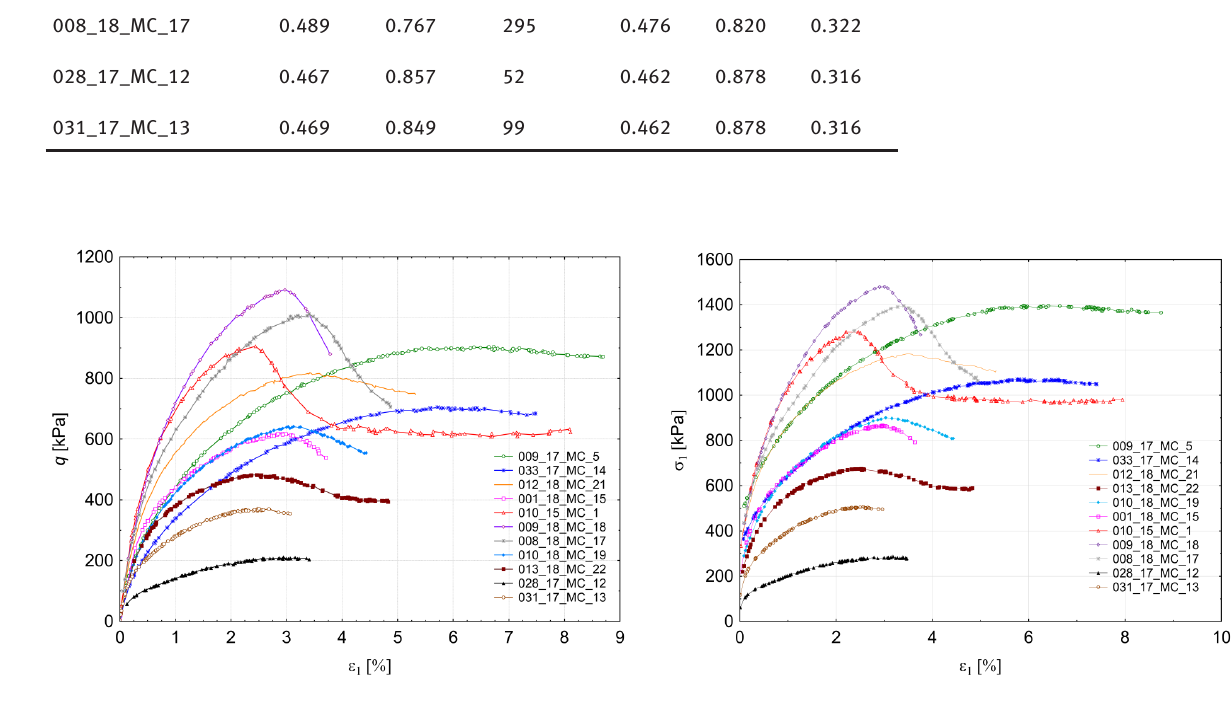
Figure 8: Results of the experimental tests listed in Table 1: deviator stress as a function of the axial strain q ( e